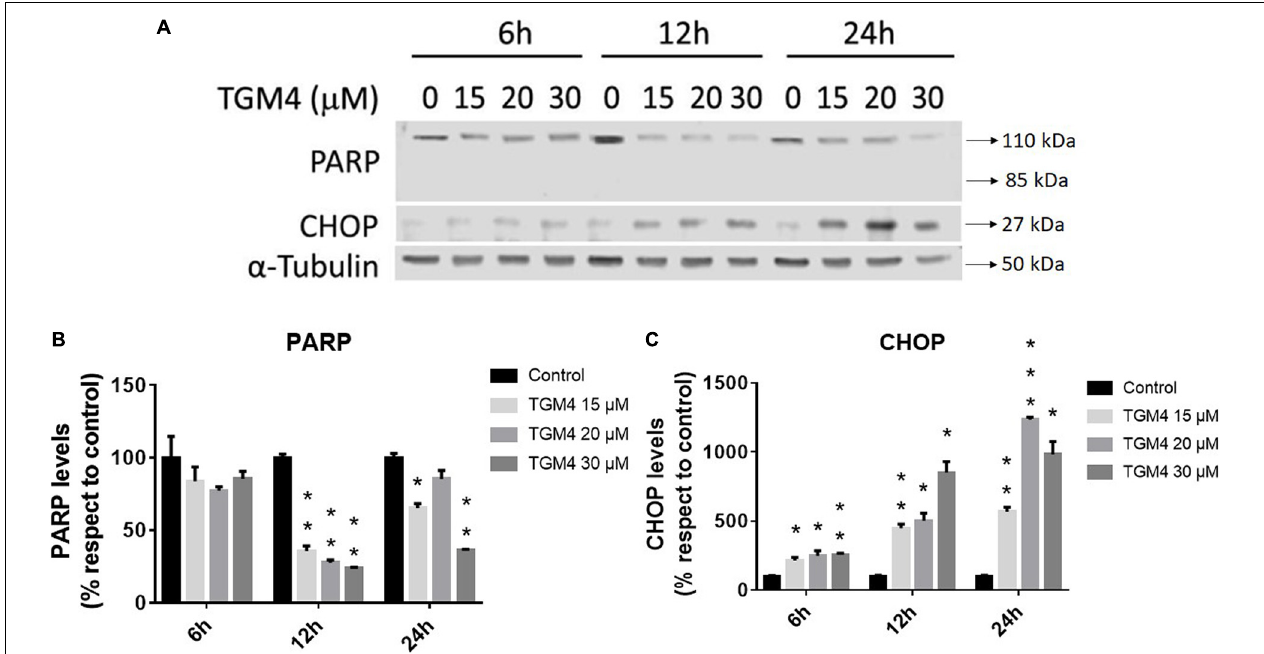
FIGURE 4 | Protein expression analysis of PANC-1 cells treated with TGM4 at different doses and times. Representative immunoblots (A) and quantification (B,C) of PARP-1 and CHOP proteins. Data were normalized by α -tubulin. Each value represents the mean ± SEM ( n = 3) expressed as a percentage with respect to control (100%). The significance was determined by a t -test (* p < 0.05; ** p < 0.01; *** p < 0.001).